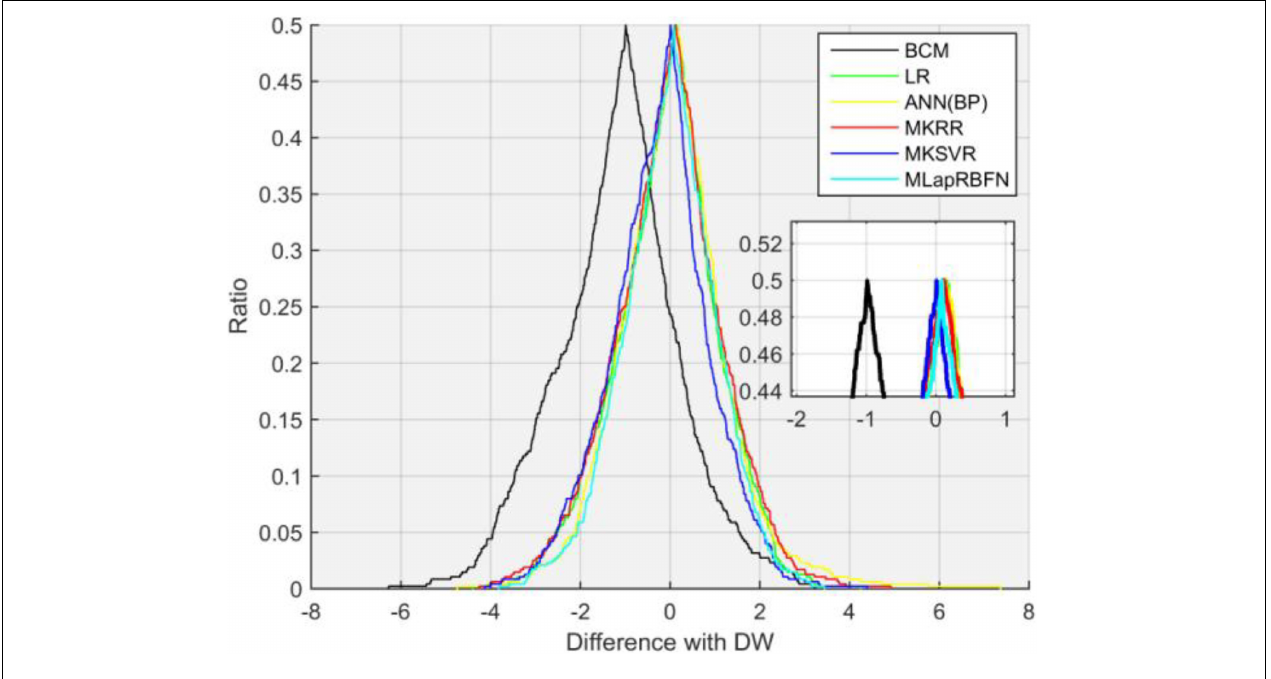
FIGURE 5 | Folded empirical cumulative distribution curves of six